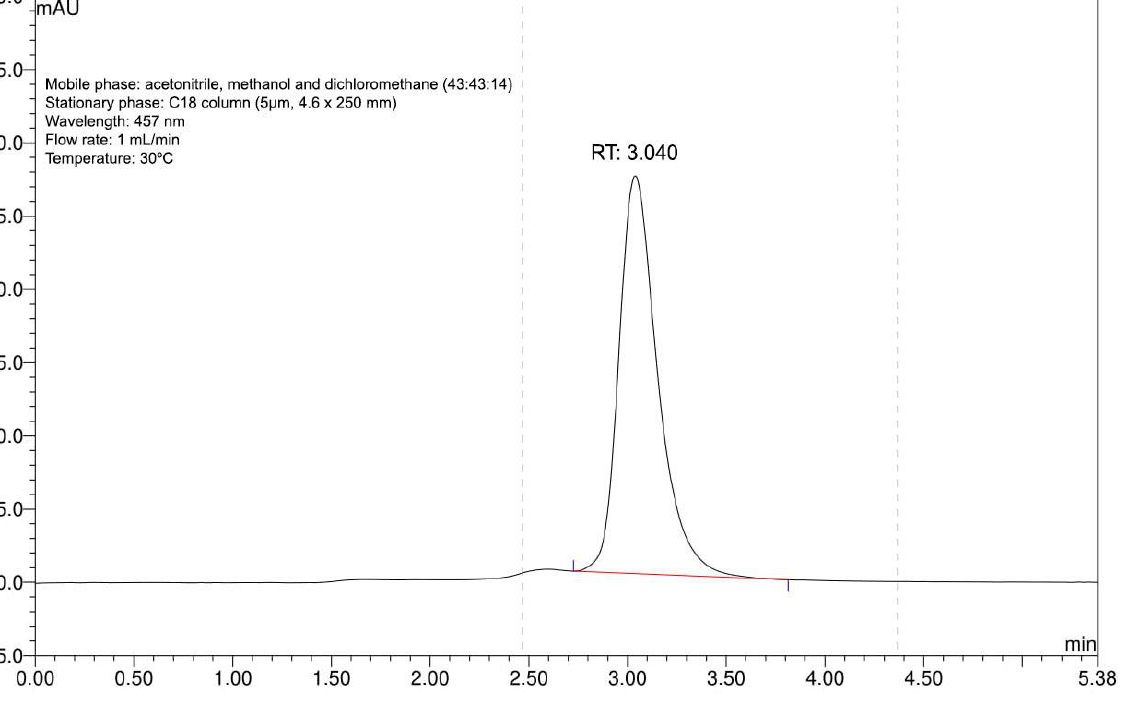
Figure 1. Annatto seed extract chromatogram. Identity confirmation of bixin with compliance retention time (RT) at 457 nm and standardized chromatographic parameters.